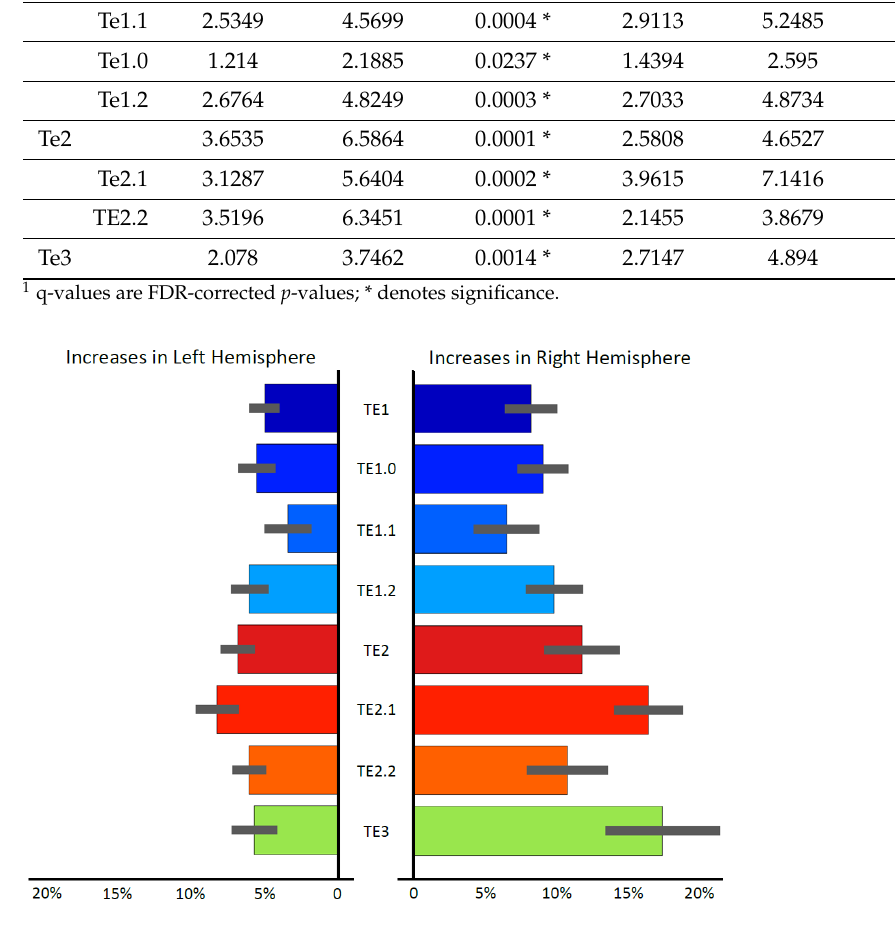
Figure 1. Changes in region-specific volumes between immediate and late postpartum. The colored bars show the mean increase in percent (%) in blue hues for Te1 (consisting of Te1.0, Te1.1, and Te1.2), in red hues for Te2 (consisting of Te2.1 and Te2.2), and in green for Te3. The smaller gray bars indicate the standard error of the